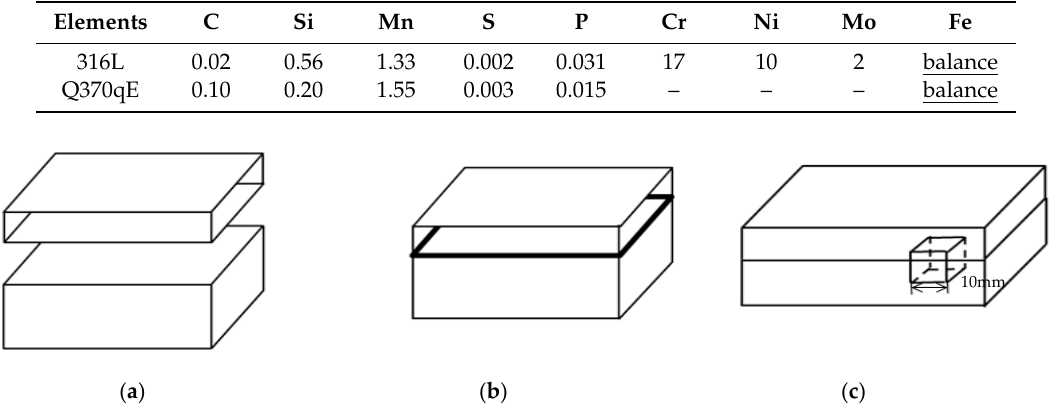
Figure 1. Schematic representation of the process for 316L/Q370qE clad plate ( a ) surface treatment and stacking; ( b ) hot rolling; ( c ) sampling schematic.